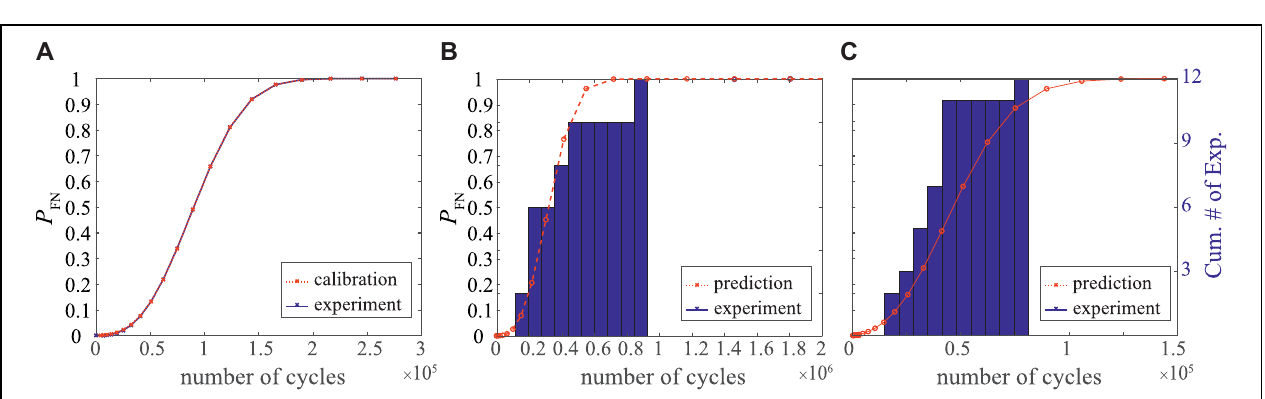
FIGURE 9 | Probability of fatigue nucleation P FN as a function of load cycles: (A) calibration at 91.5% of yield stress; (B) prediction at 85.8% of yield stress and (C) prediction at 95.5% of yield